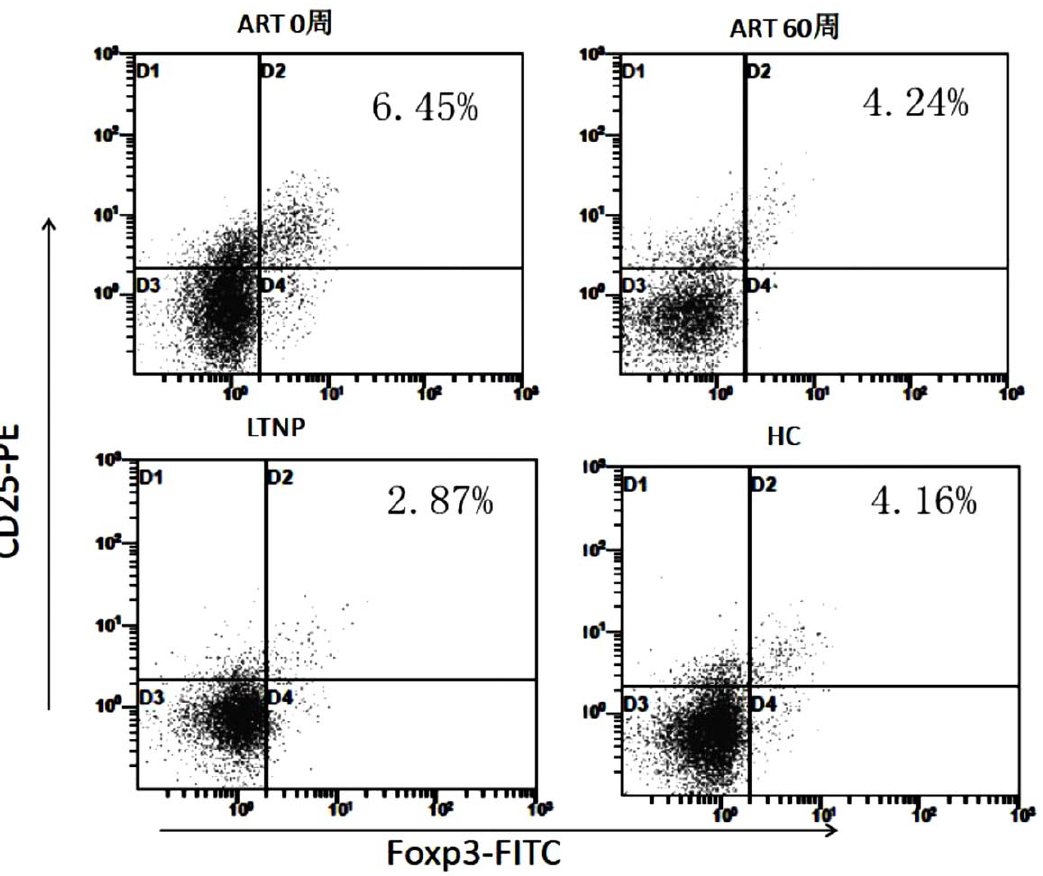
Figure 6. Representative plots of CD4 + CD25 + FoxP3 + Tregs from individual subjects in the HIV-1-infected patients at week 0, week 60, healthy controls and